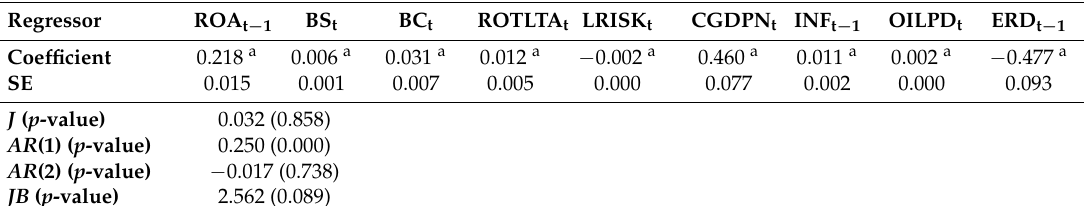
Table 5 documents the estimation results. Table 5. GMM estimation